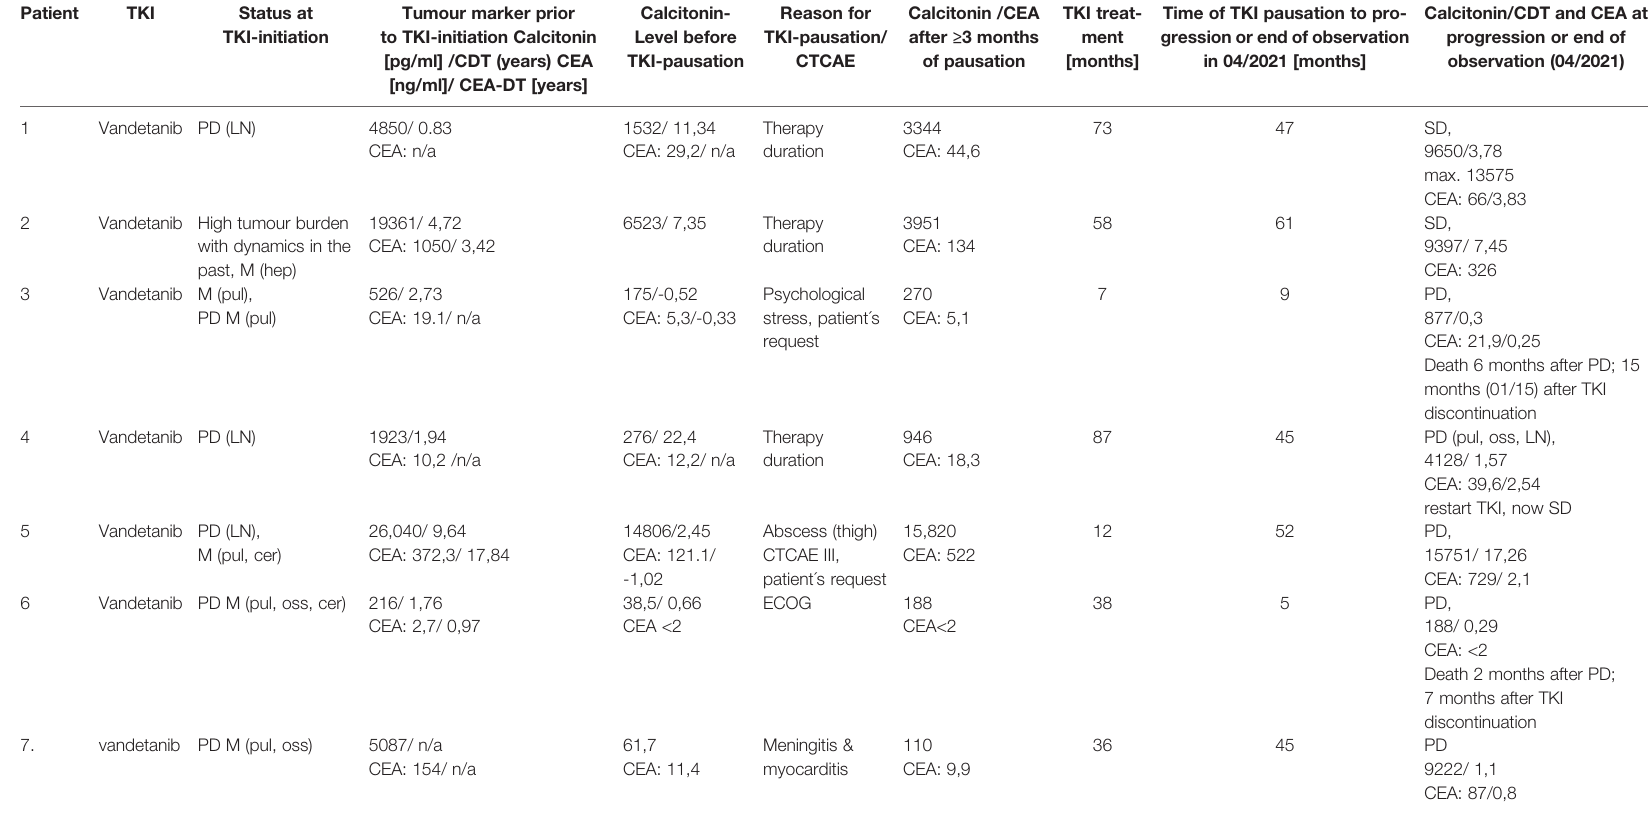
TABLE 1 | Course of disease in 6 patients with sporadic medullary thyroid carcinoma (sMTC) and in 1 patient with MEN2a. Patient